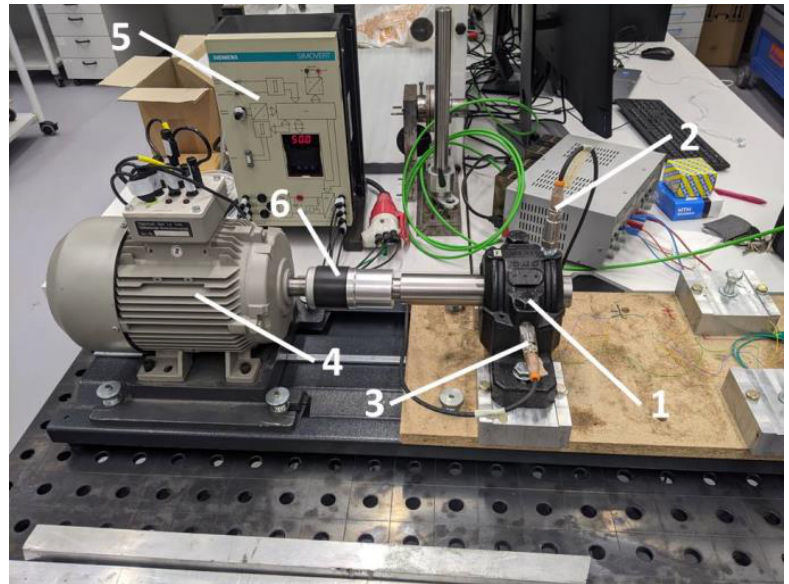
Figure 8. Experimental setup: 1—Plummer block with mounted ball bearing, 2—Vertical accelerometer, 3—Horizontal accelerometer, 4—Electric motor, 5—Inverter, 6—Coupling.